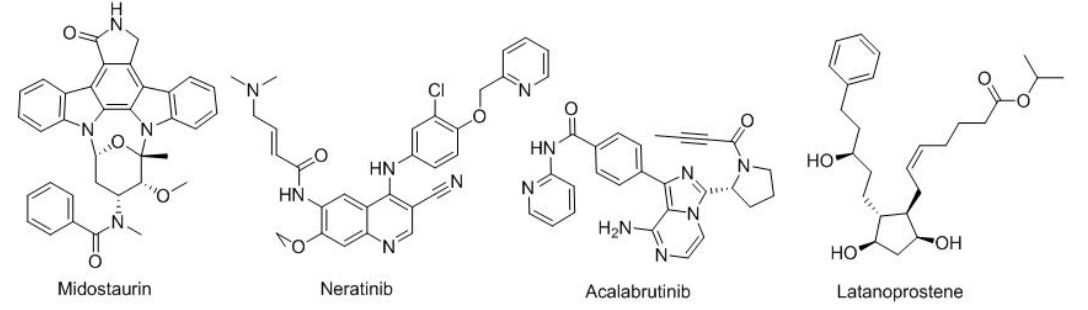
Figure 13. Structure of midostaurin, neratinib, acalabrutinib, and latanoprostene.